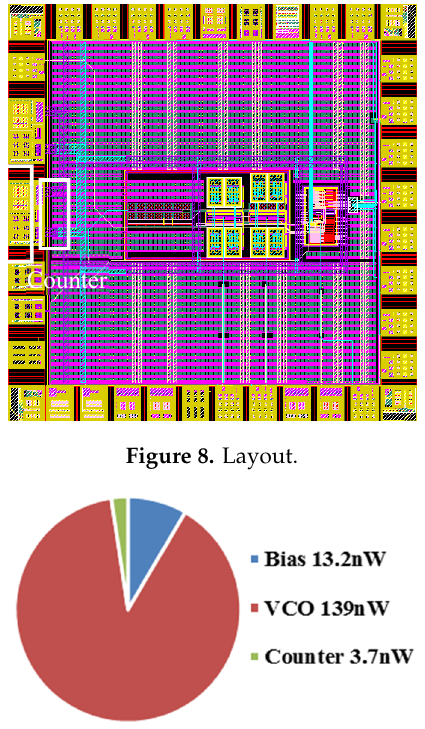
Figure 9. Power breakdown.